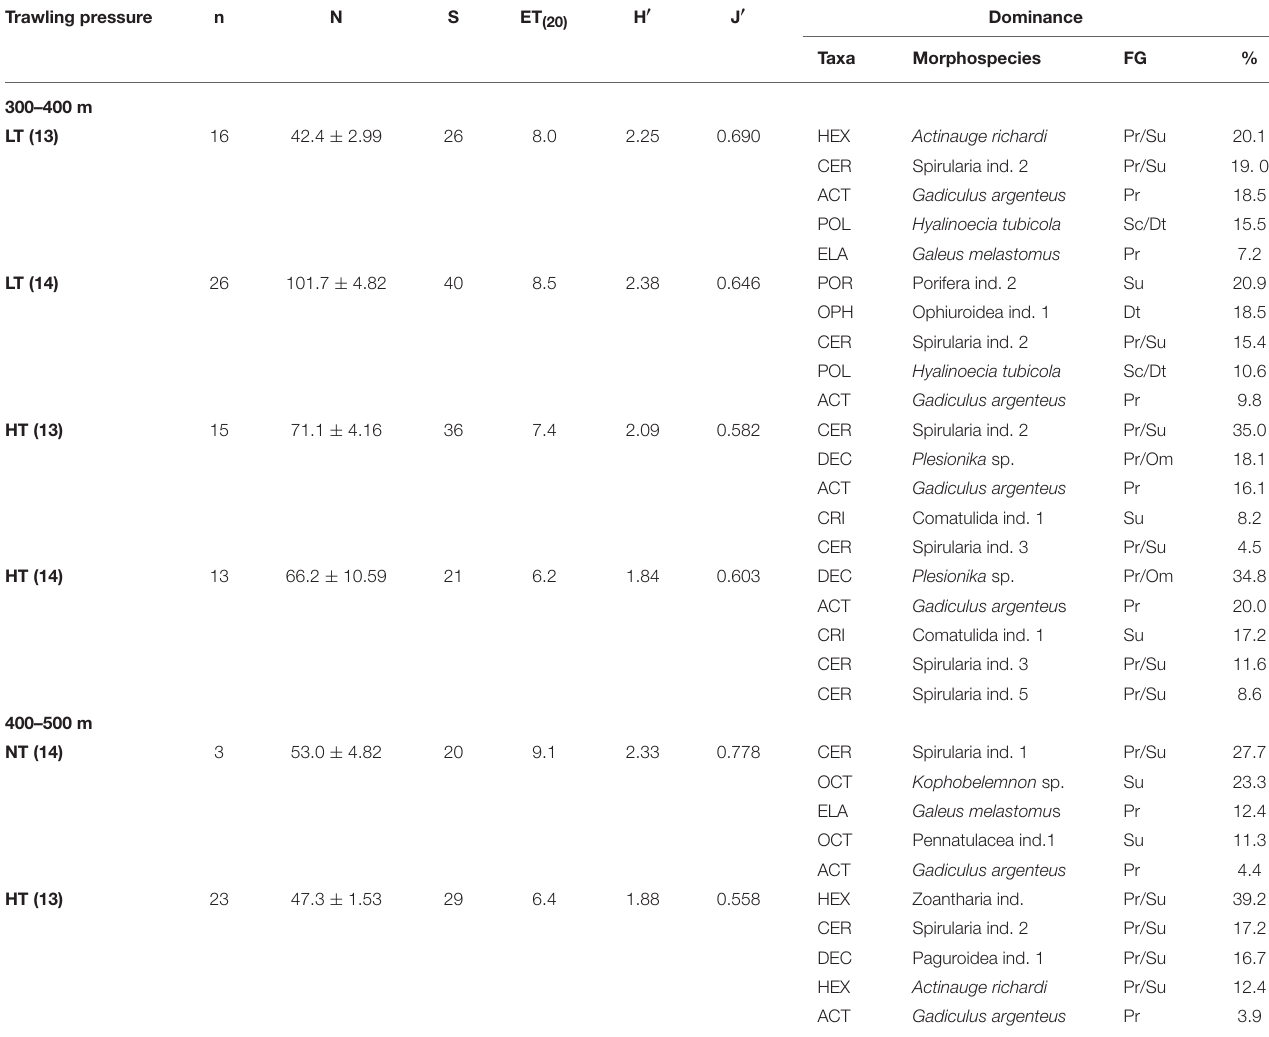
TABLE 5 | Abundance and biodiversity results from muddy-sand sediment areas at subjected to varying trawling disturbance (selected dataset). Trawling pressure n N S ET (20) J